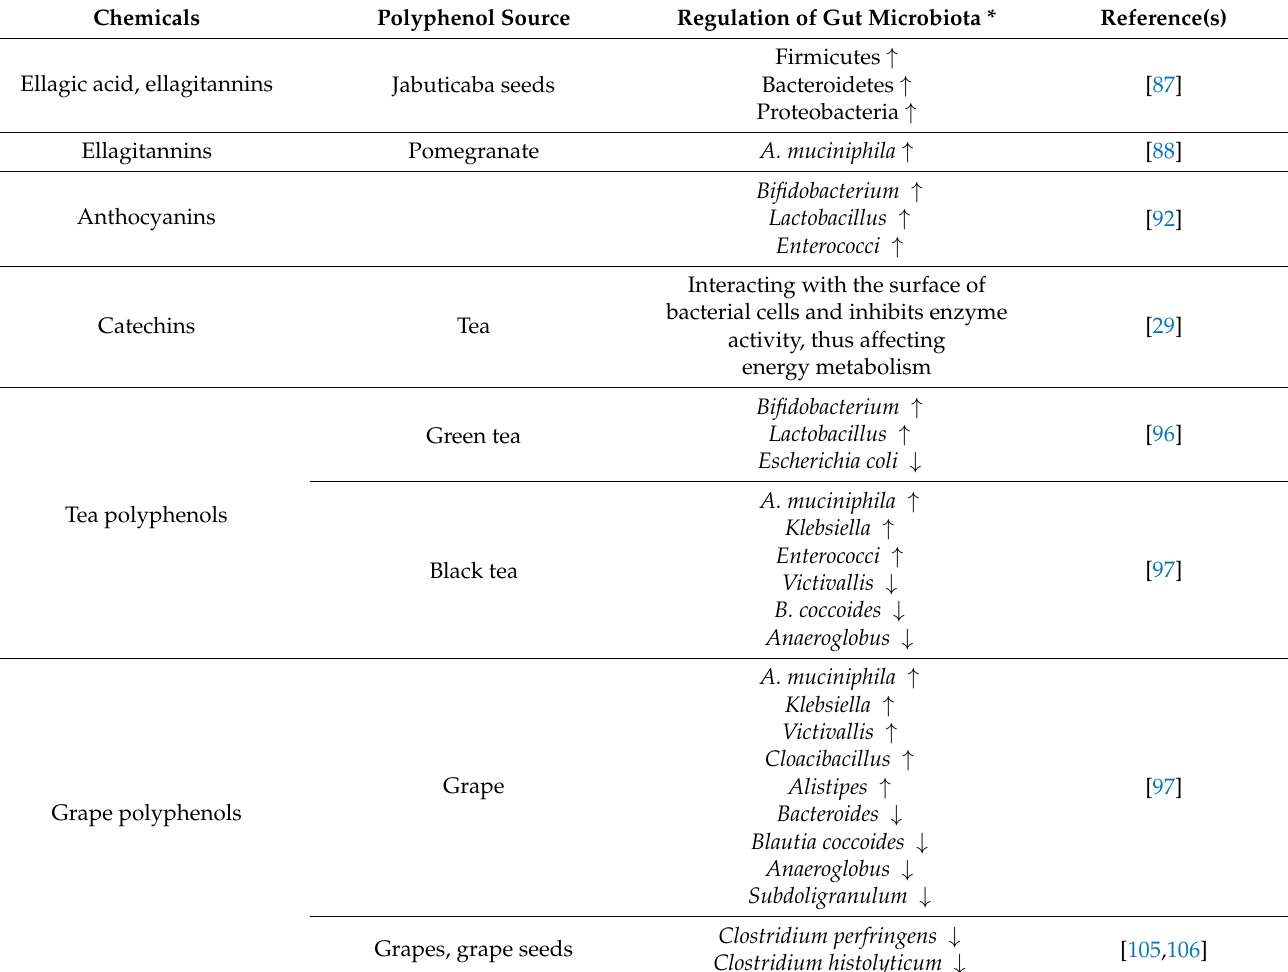
Table 2. Effects of different polyphenols on gut